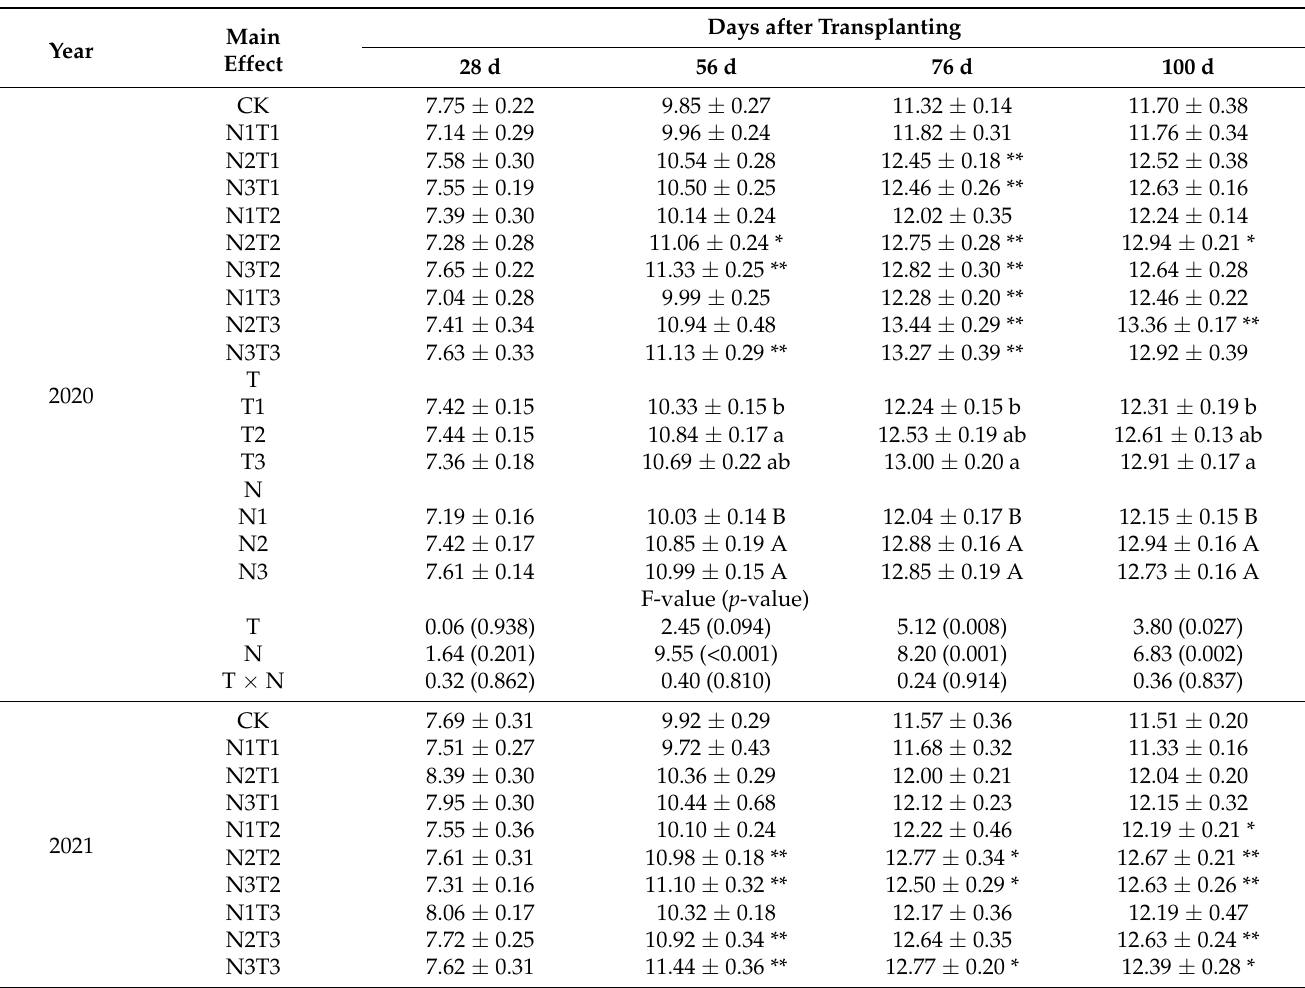
Table 5. Response of tomato stem diameter (SD, mm) to different urea types and N application rates in the